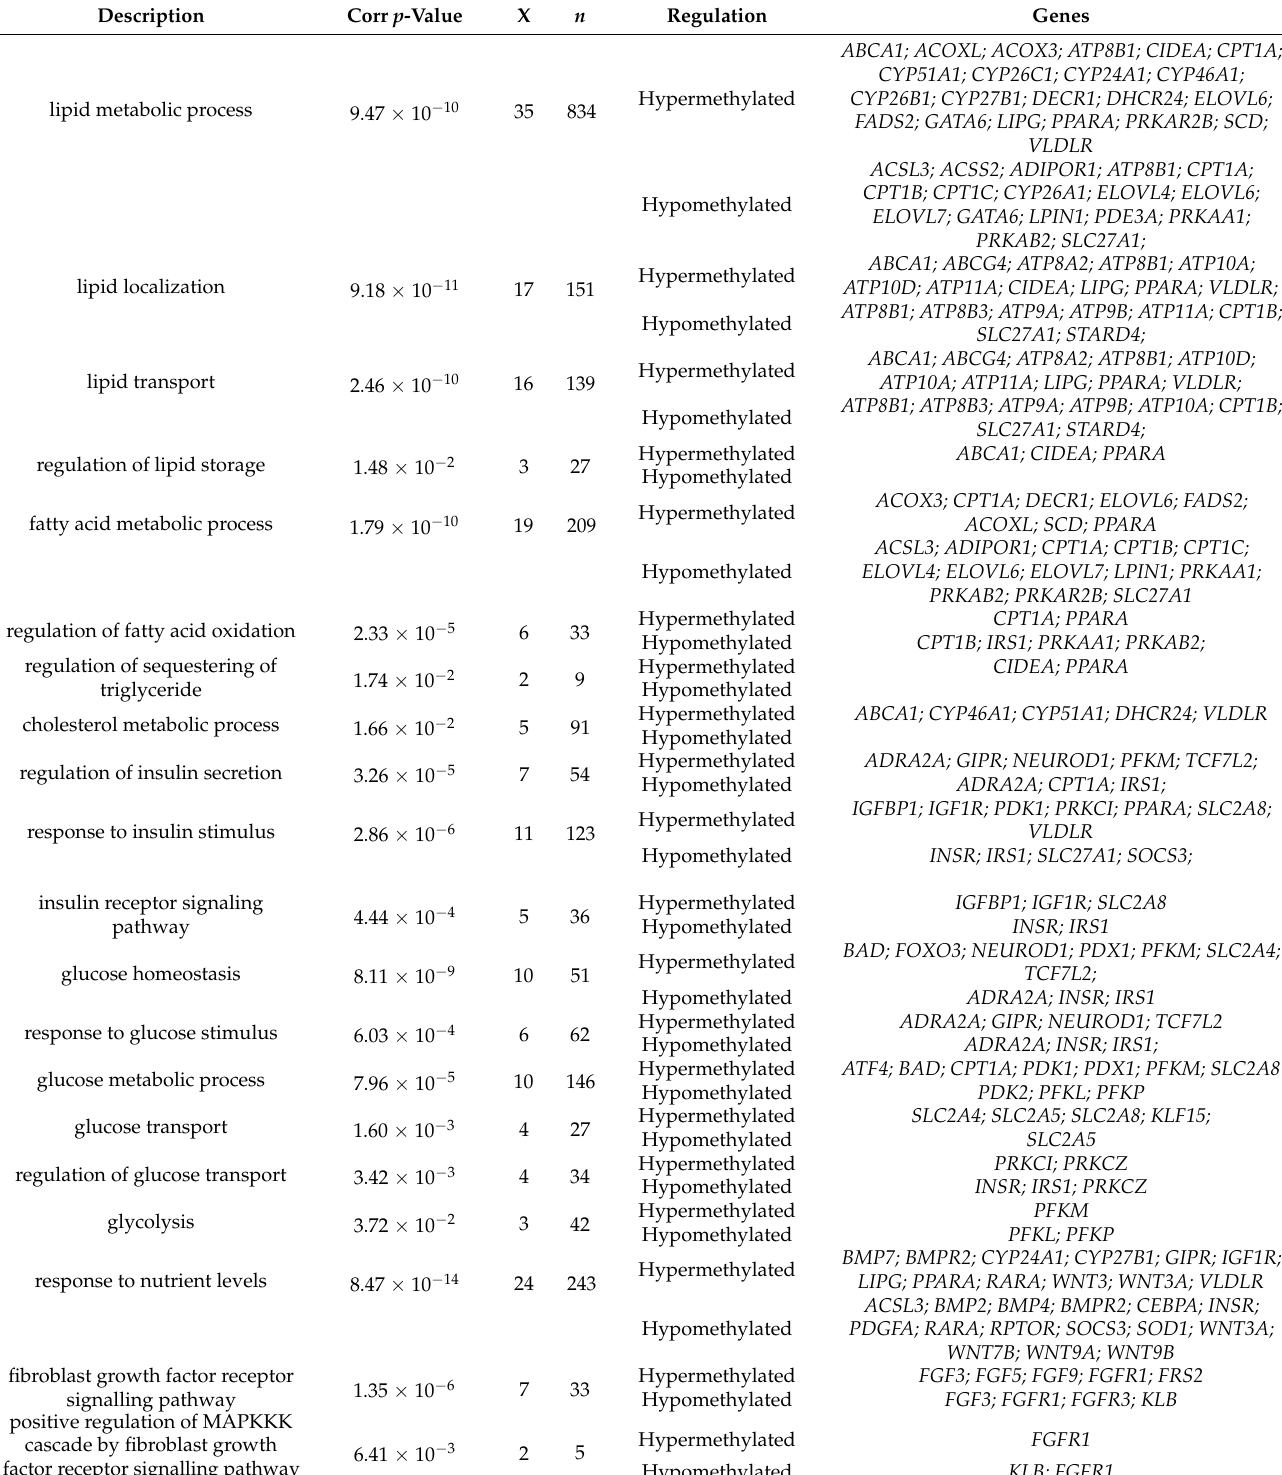
Table 2. Results of biological processes of differentially methylated genes-generated in Cytoscape software through BinGo